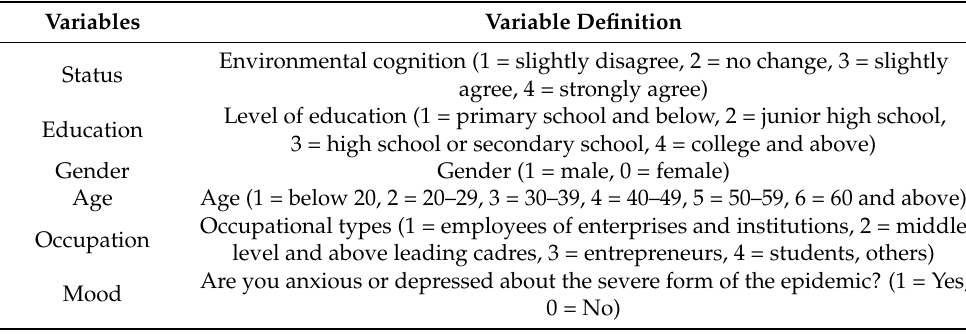
Table 1. Variable setting and meaning in the multiple logistic